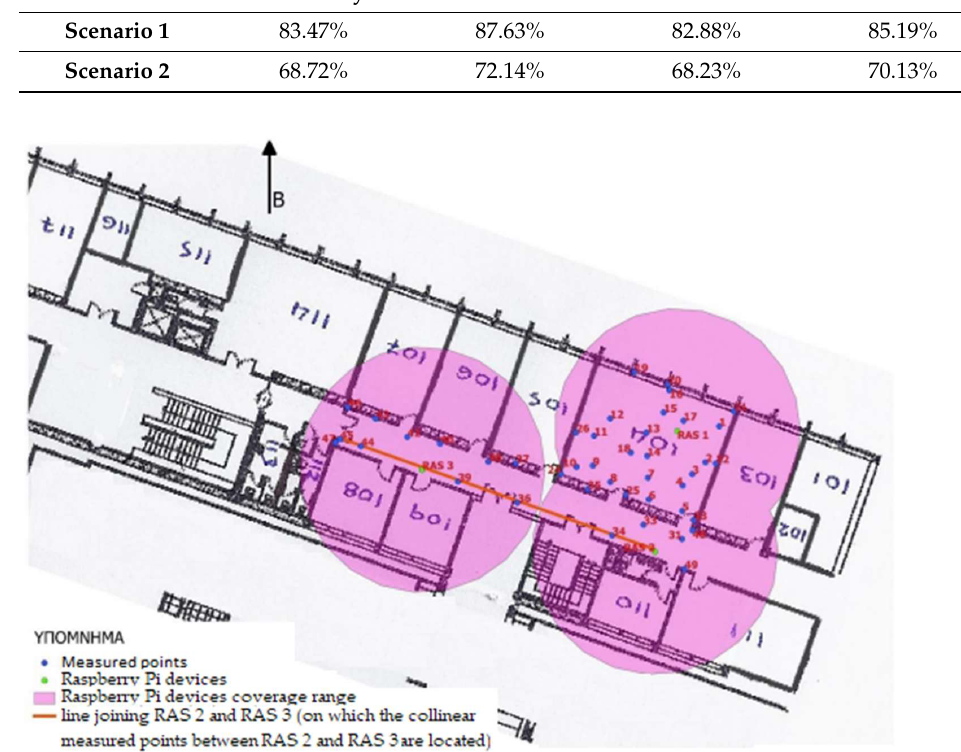
Figure 8. The coverage range of RAS1, RAS2 and RAS3 (in pink) in scenario